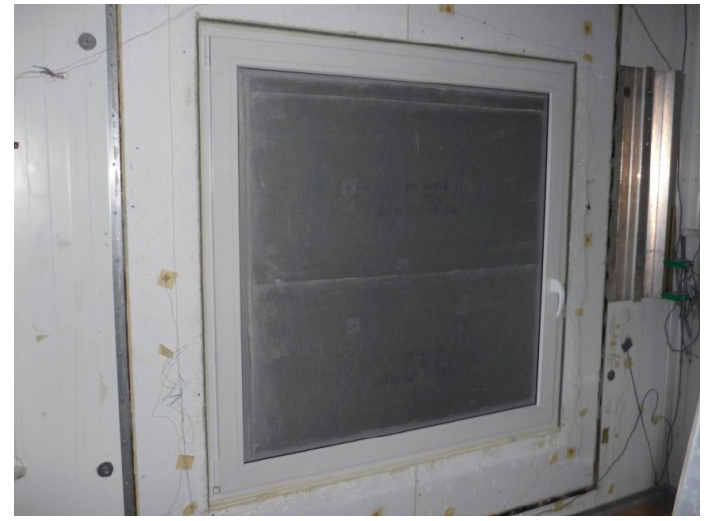
Figure 8. View of the tested window frame in the surround panel on the warm side.